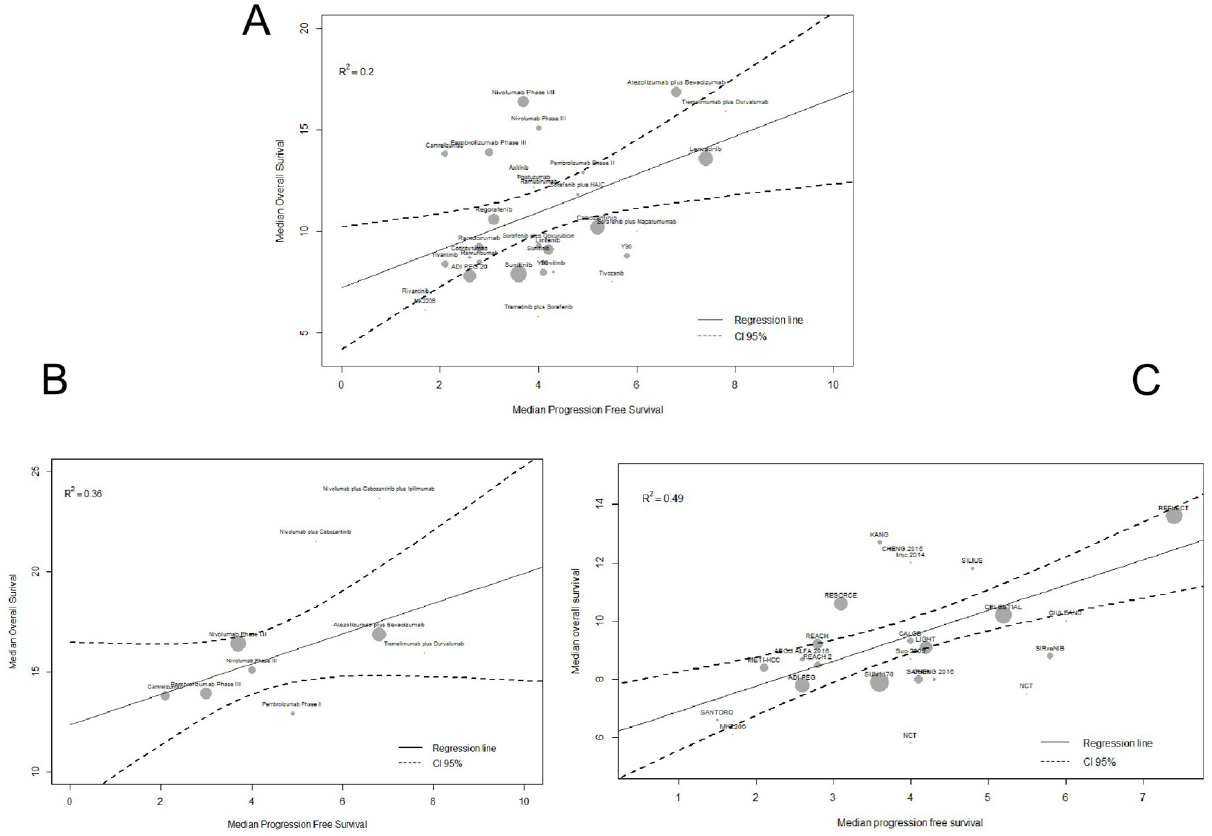
Figure 3. Meta-regression analysis of the relationship between median PFS and median OS in clinical trials of systemic therapies for advanced HCC. ( A ) Overall. ( B ) ICI trials. ( C ) MKI